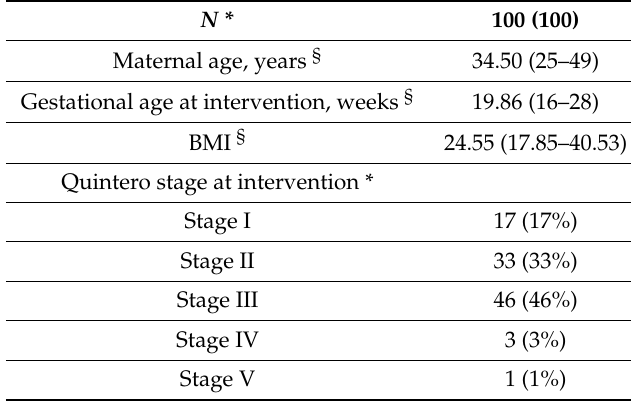
Table 1. Patient characteristics and Quintero stage at intervention.